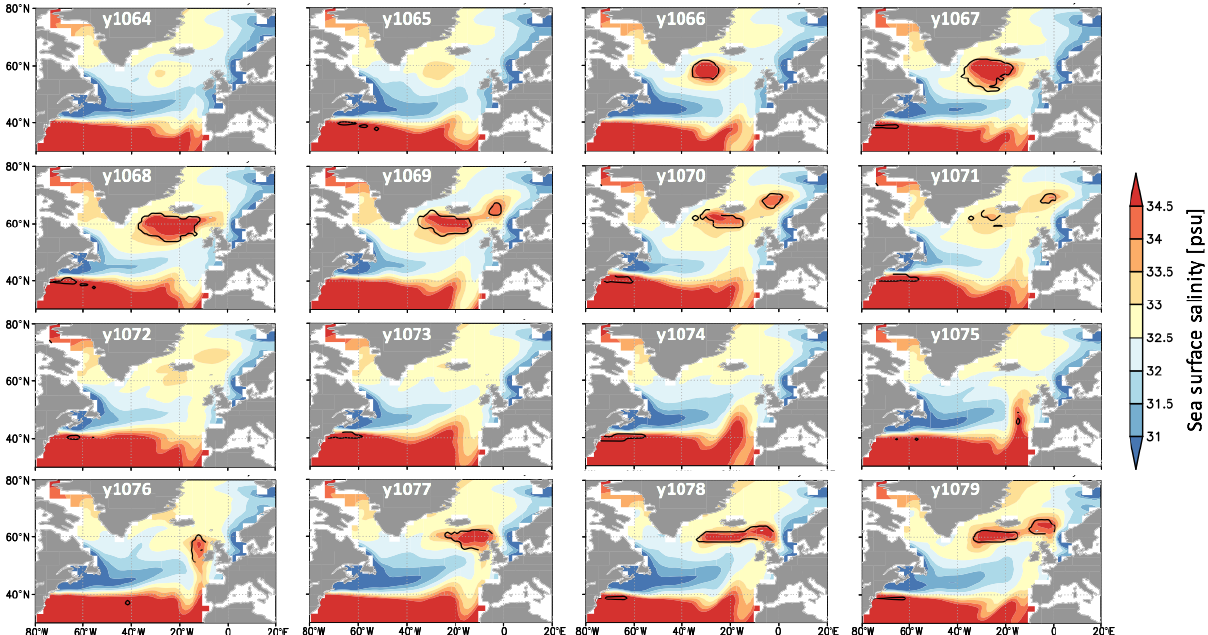
Figure 9. Spatial maps of the temporal evolution of surface salinity (color, psu) and the frequency of convective adjustment at 300m depth (black contours, non-dimensional) in MIS3–5aiceH. Annual means are shown. The value of the contour is